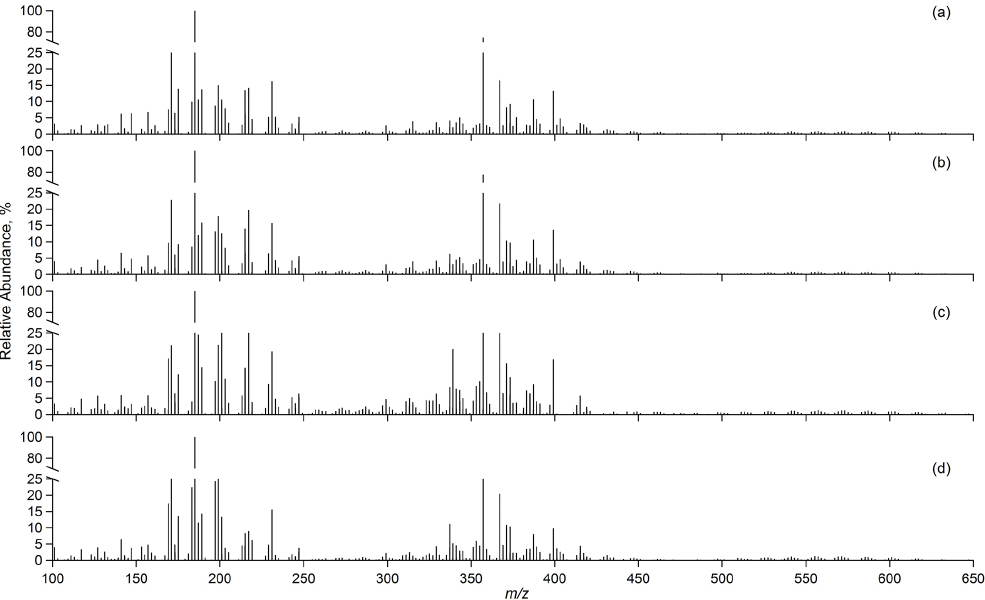
Figure 1. Direct infusion (-) nanoESI HRMS of SOA from dark ozonolysis of BVOC mixture: (a) fresh aerosol, (b) aged for 9h in dark (with residual ozone), (c) aged for 8h in the presence of O 3 , H 2 O 2 and UV light and (d) aged for 9h in the presence of O 3 and UV light.